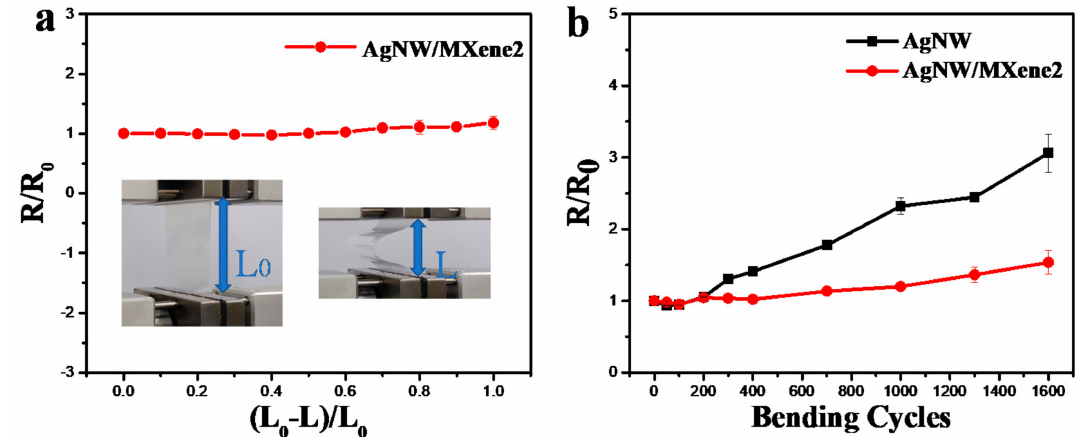
Figure 5. ( a ) Change in resistance of AgNW/MXene TCF to different bending ratios. ( b ) R/R 0 of AgNW/MXene films as a function of bending